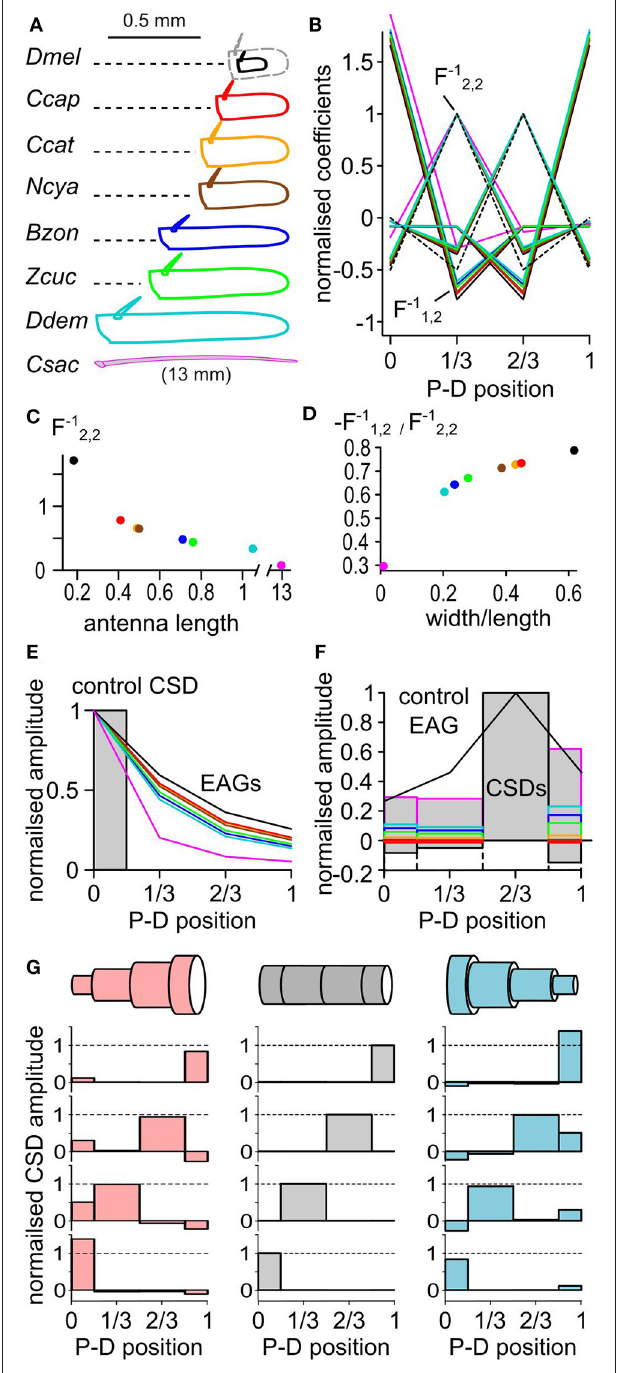
FIGURE 6 | The CSD model depends on the geometry of the antenna. (A) The dimensions of the funiculus (length and width) were measured in seven insect species: D. melanogaster ( Dmel ), C. capitata ( Ccap ), C. catoirii ( Ccat ), N. cyanescens ( Ncya ), B. zonata ( Bzon ), Z. cucurbitae ( Zcuc ), and D. demmerezi ( Ddem ). The drawing of the funiculus was reshaped to match the average length and width for each species ( n = 10 per species). Since D. melanogaster funiculus is small, it was proportionally enlarged (dotted gray